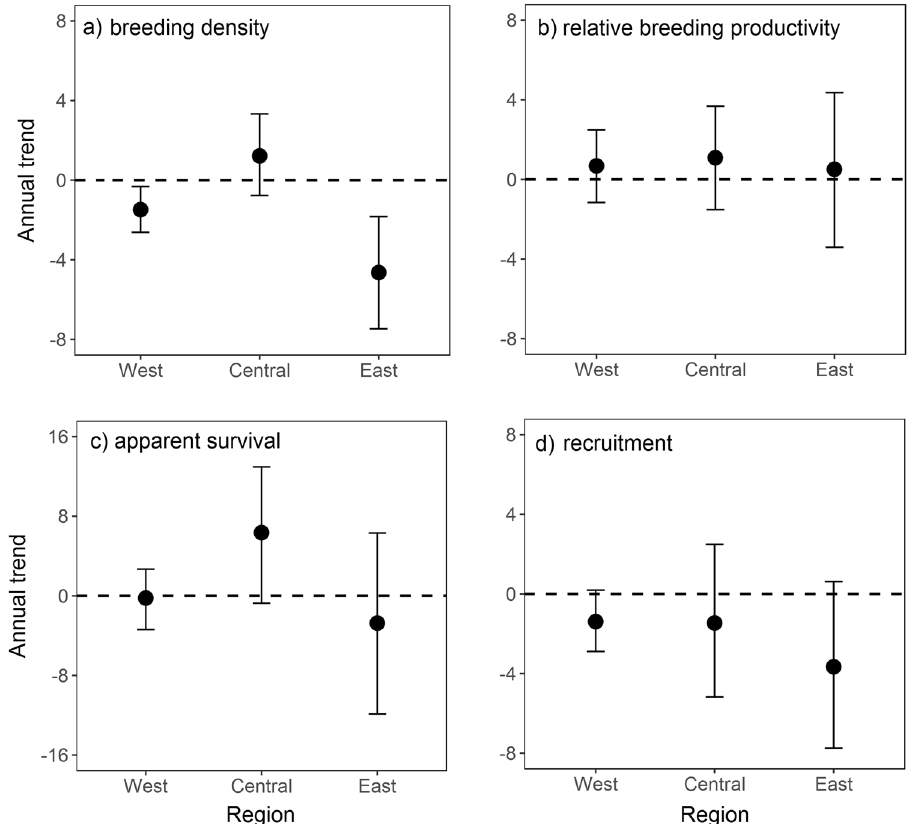
Figure 2. Annual trend coefficients and 90% credible intervals for breeding density, relative breeding productivity, apparent annual survival of breeders and annual recruitment of Canada warblers. Upper credible intervals below 0 indicate a greater than 90% probability of a decline over the course of the study (1993–2016). Note the different scale for the y-axis for apparent survival.